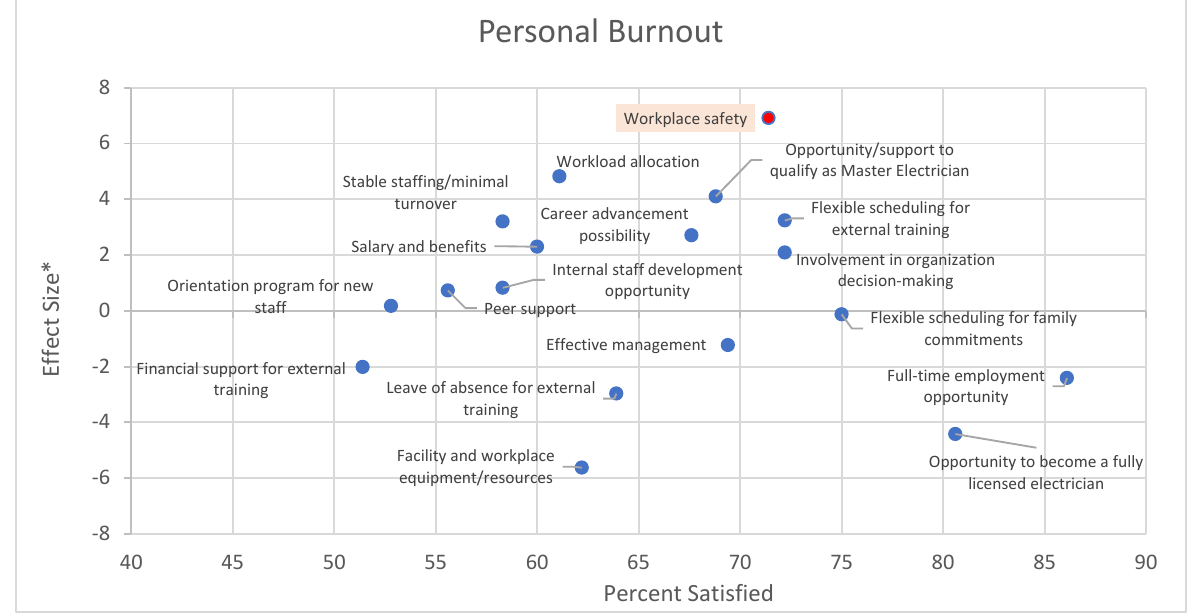
Figure 3. Impact of availability of work-related factors on personal burnout. * Effect sizes is the difference in the average burnout score among those satisfied and those dissatisfied with the factor. Thus, positive effect sizes indicate higher burnout among those dissatisfied with the factor. The proportion satisfied is a measure of performance that indicates the proportion of the sample that stated to be satisfied or very satisfied with the availability of the factor. The red dot indicates statistical significance at an alpha level of 0.10 when comparing the average burnout score among respondents satisfied and dissatisfied with the factor.